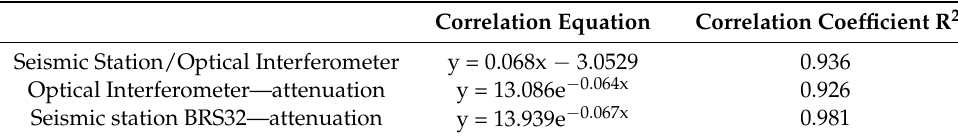
Table 1. Summary of results obtained from in situ comparative